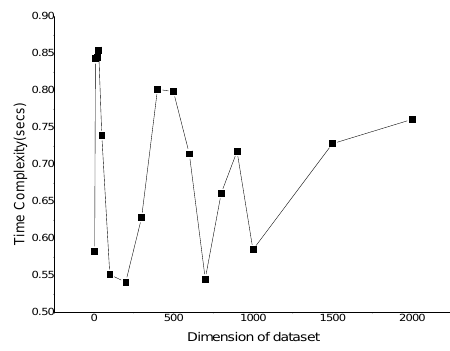
Fig. 10. Time Complexity of our optimization versus di-